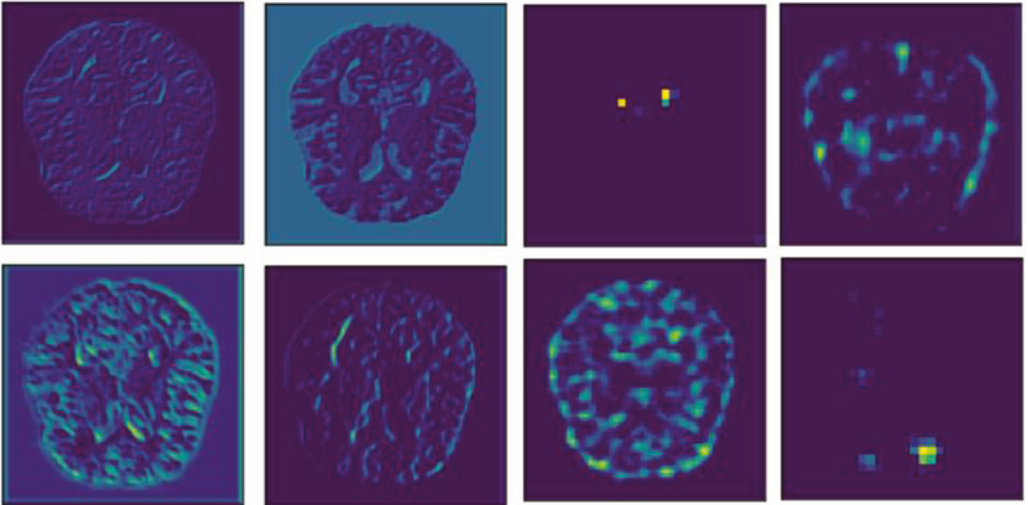
Figure 4: Deep and low-level features extracted from the